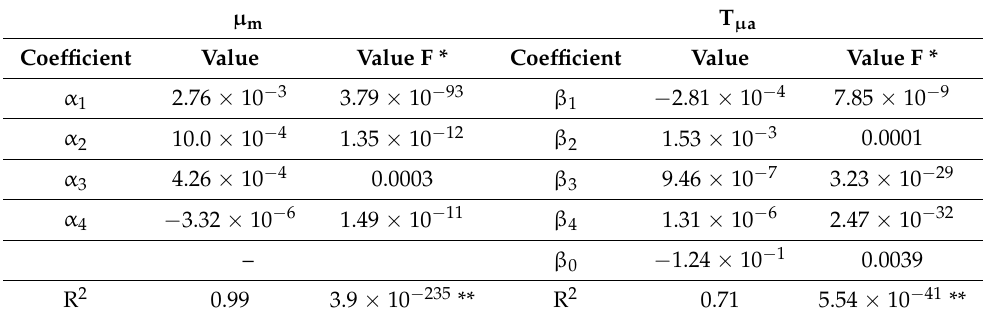
Table 9. Regression function coefficients with R 2 fitting for µ m and T µ a models after